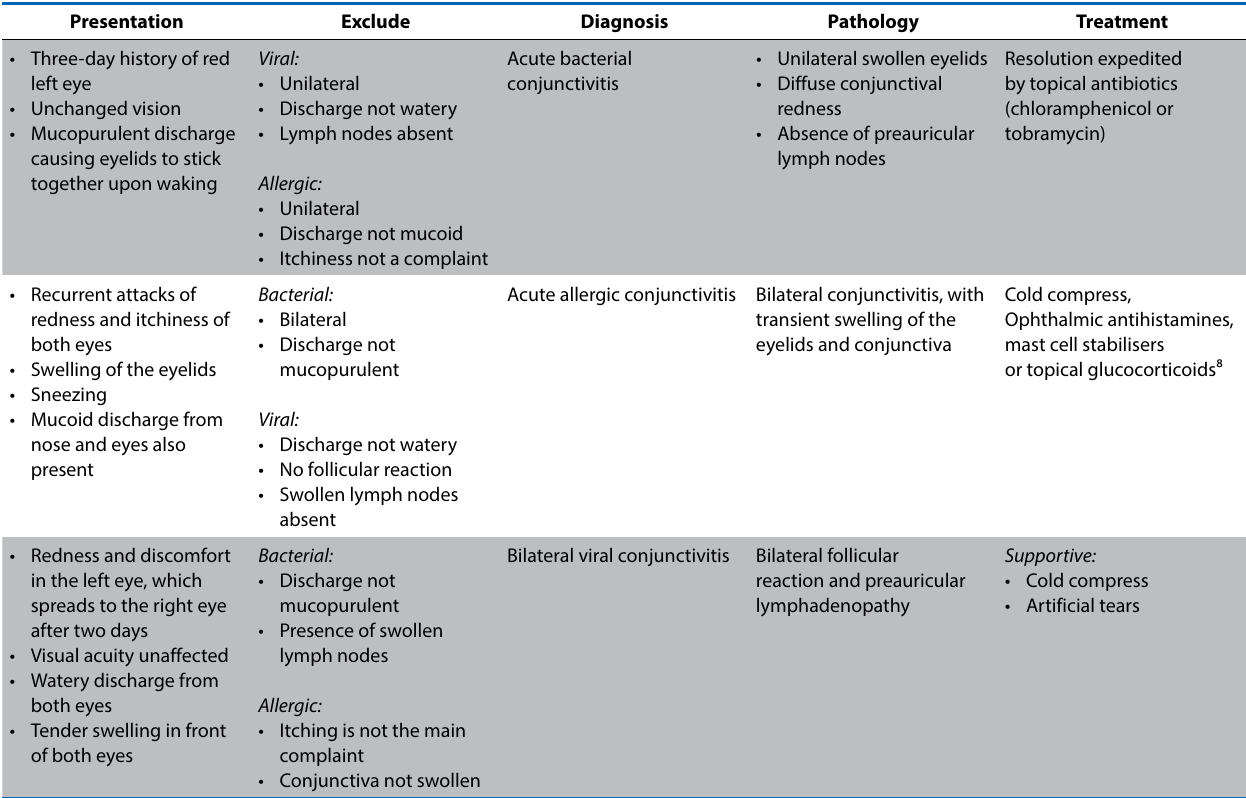
Table II: Differentiatiion between an allergy or an infection based on the presenting symptoms 7